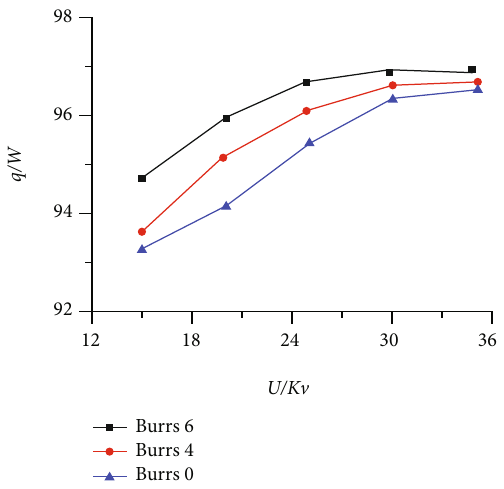
Figure 10: Corona voltage e ff ect on power of injected water mist cloud.